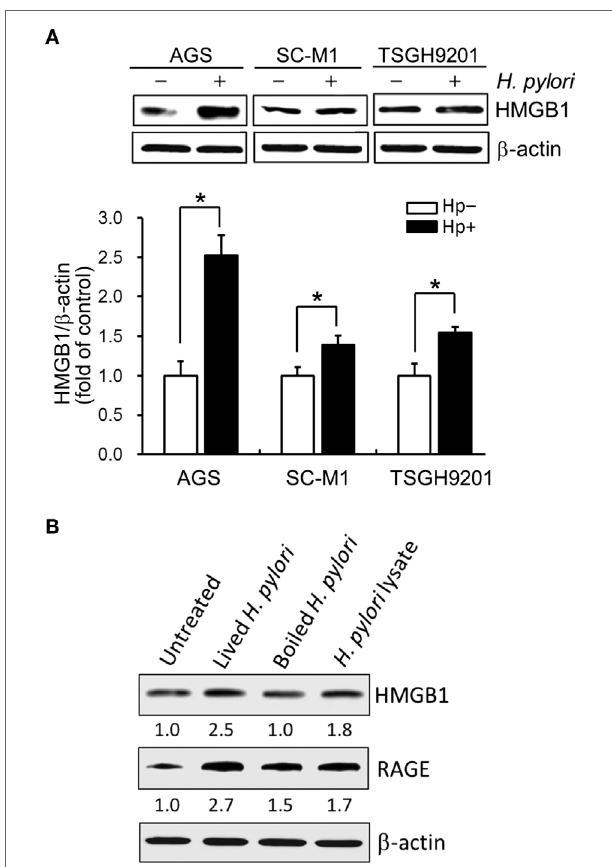
FigUre 2 | live H. pylori is essential for enhancing hMgB1 and rage expression . Gastric epithelial cell lines, AGS, SC-M1, and TSGH9201 cells, were infected with H. pylori at an MOI of 100 for 6 h. (a) Cells from these cells lines were uninfected or infected with H. pylori (MOI = 100) for 6 h. Cell lysates were prepared to analyze HMGB1 expression by Western blot. Protein expression levels were quantified by densitometric analysis and normalized to β -actin. Statistical significance was evaluated by Student’s t -test (* P < 0.05). (B) AGS cells were untreated or treated with live H. pylori or heat-killed H. pylori (boiled H. pylori ) at an MOI of 100, or crude extracts prepared from H. pylori ( H. pylori lysate). Cell lysates were prepared to measure HMGB1 and RAGE protein expression by Western blot, with β -actin was used as the protein loading control. The expression level of each protein was quantified by signal intensity, and the respective value is indicated at the bottom of each